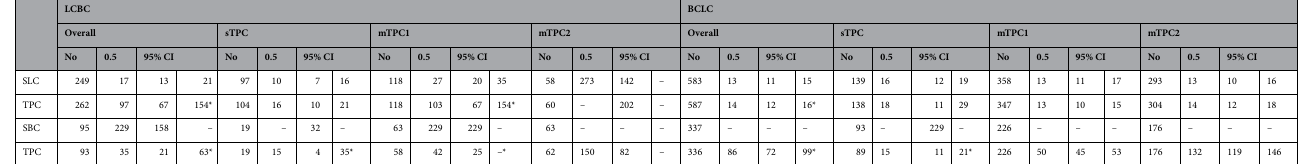
survival relative to the corresponding single lung cancer (median survival times of PCLC and SLC were 17 and 12 months, respectively; PCLC vs. SLC: Coef. − 0.32, 95% CI − 0.43 to 0.22; SHR 0.77, 95% CI 0.69–0.85). However, prognosis values of LCPC and PCLC were generally inferior to that of matched single prostate cancer (Tables 3, s10–s16, Figs. 1, 2, 3 and 4). Survival analysis among sTPC, mTPC1, and mTPC2 groups. The median overall survival times since lung malignancy in patients with LCBC and BCLC were 103 and 11 months, respectively. The median overall survival times since lung primary of sTPC, mTPC1, and mTPC2 groups were 16, 92, and 345 months,